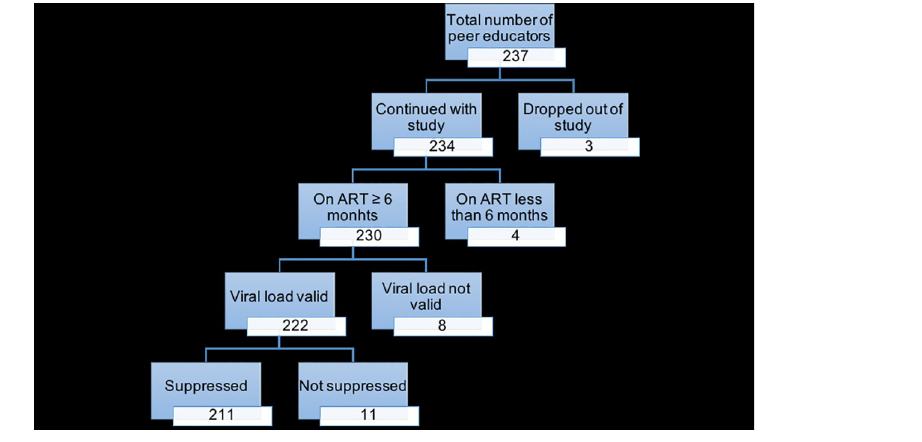
Fig 1. Participant enrollment into the